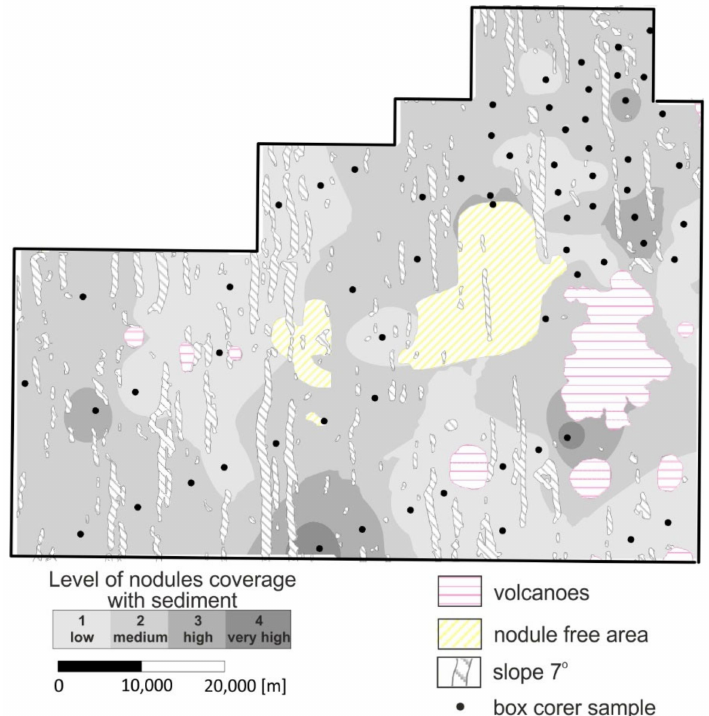
Figure7. Mapofnodulecoveragewithbottomsedimentsvisuallyestimatedbasedonseafloorphotography (exploration block